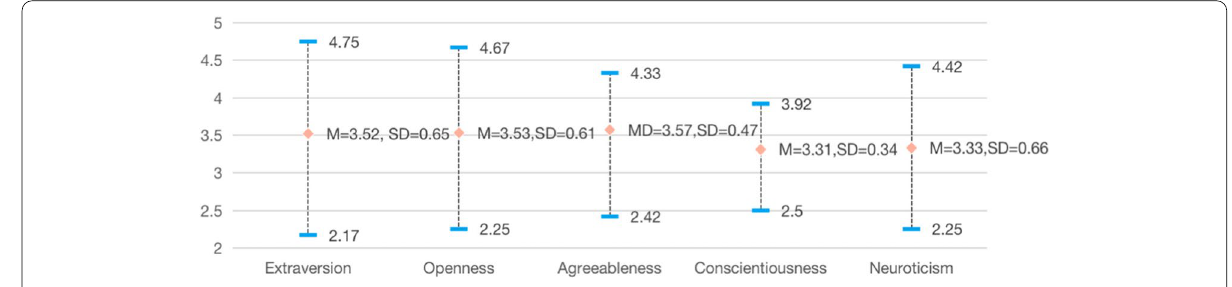
Fig. 6 Descriptive statistics for Big Five